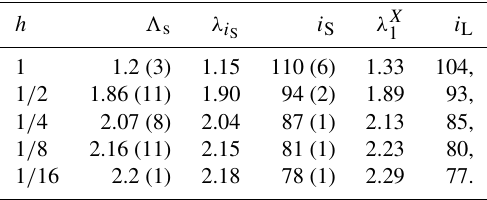
Table 2. Estimated slow dynamics finite-size instability (cid:51) s (h) com- pared to the closest LE and its index i S for different coupling con- stants. Numbers in parenthesis refer to the uncertainty in (cid:51) S and, accordingly, of i S . Results of the restricted analysis carried on in Sect. 4 are reported from Table 1 for comparison. All data have been obtained with b = 10, K = 36 and J =